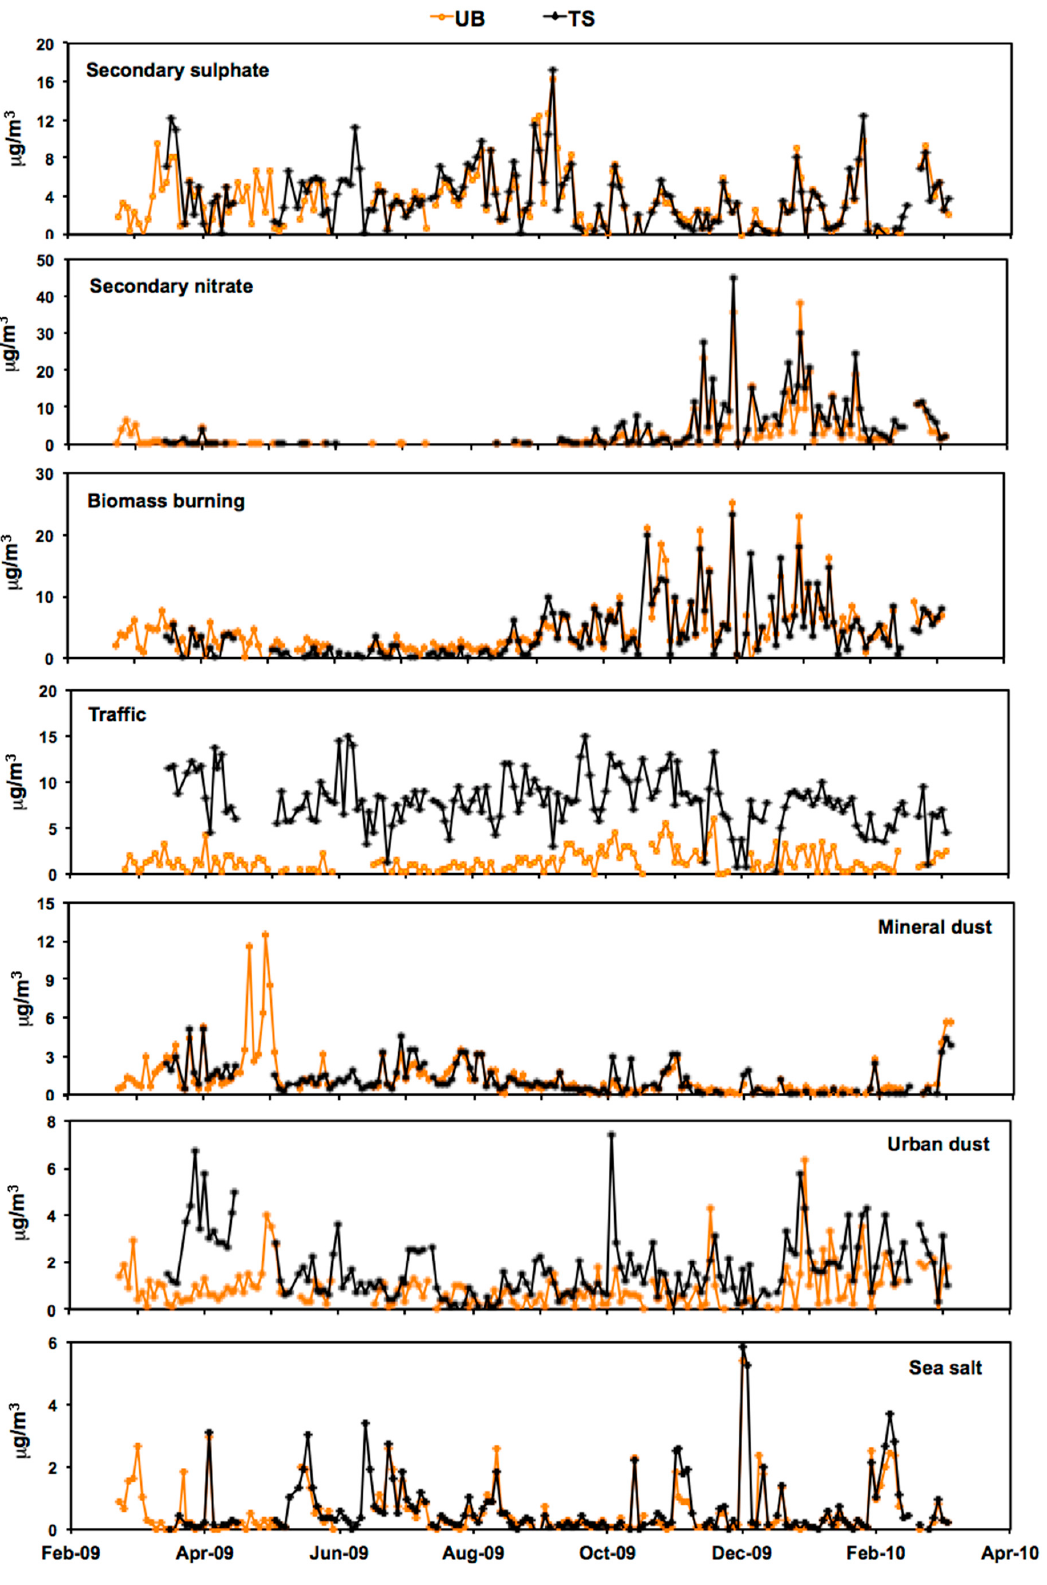
Figure 6. Daily source contributions in the urban background (UB, orange dots) and traffic site (TS, black dots). Gaps are due to sampler malfunctioning.